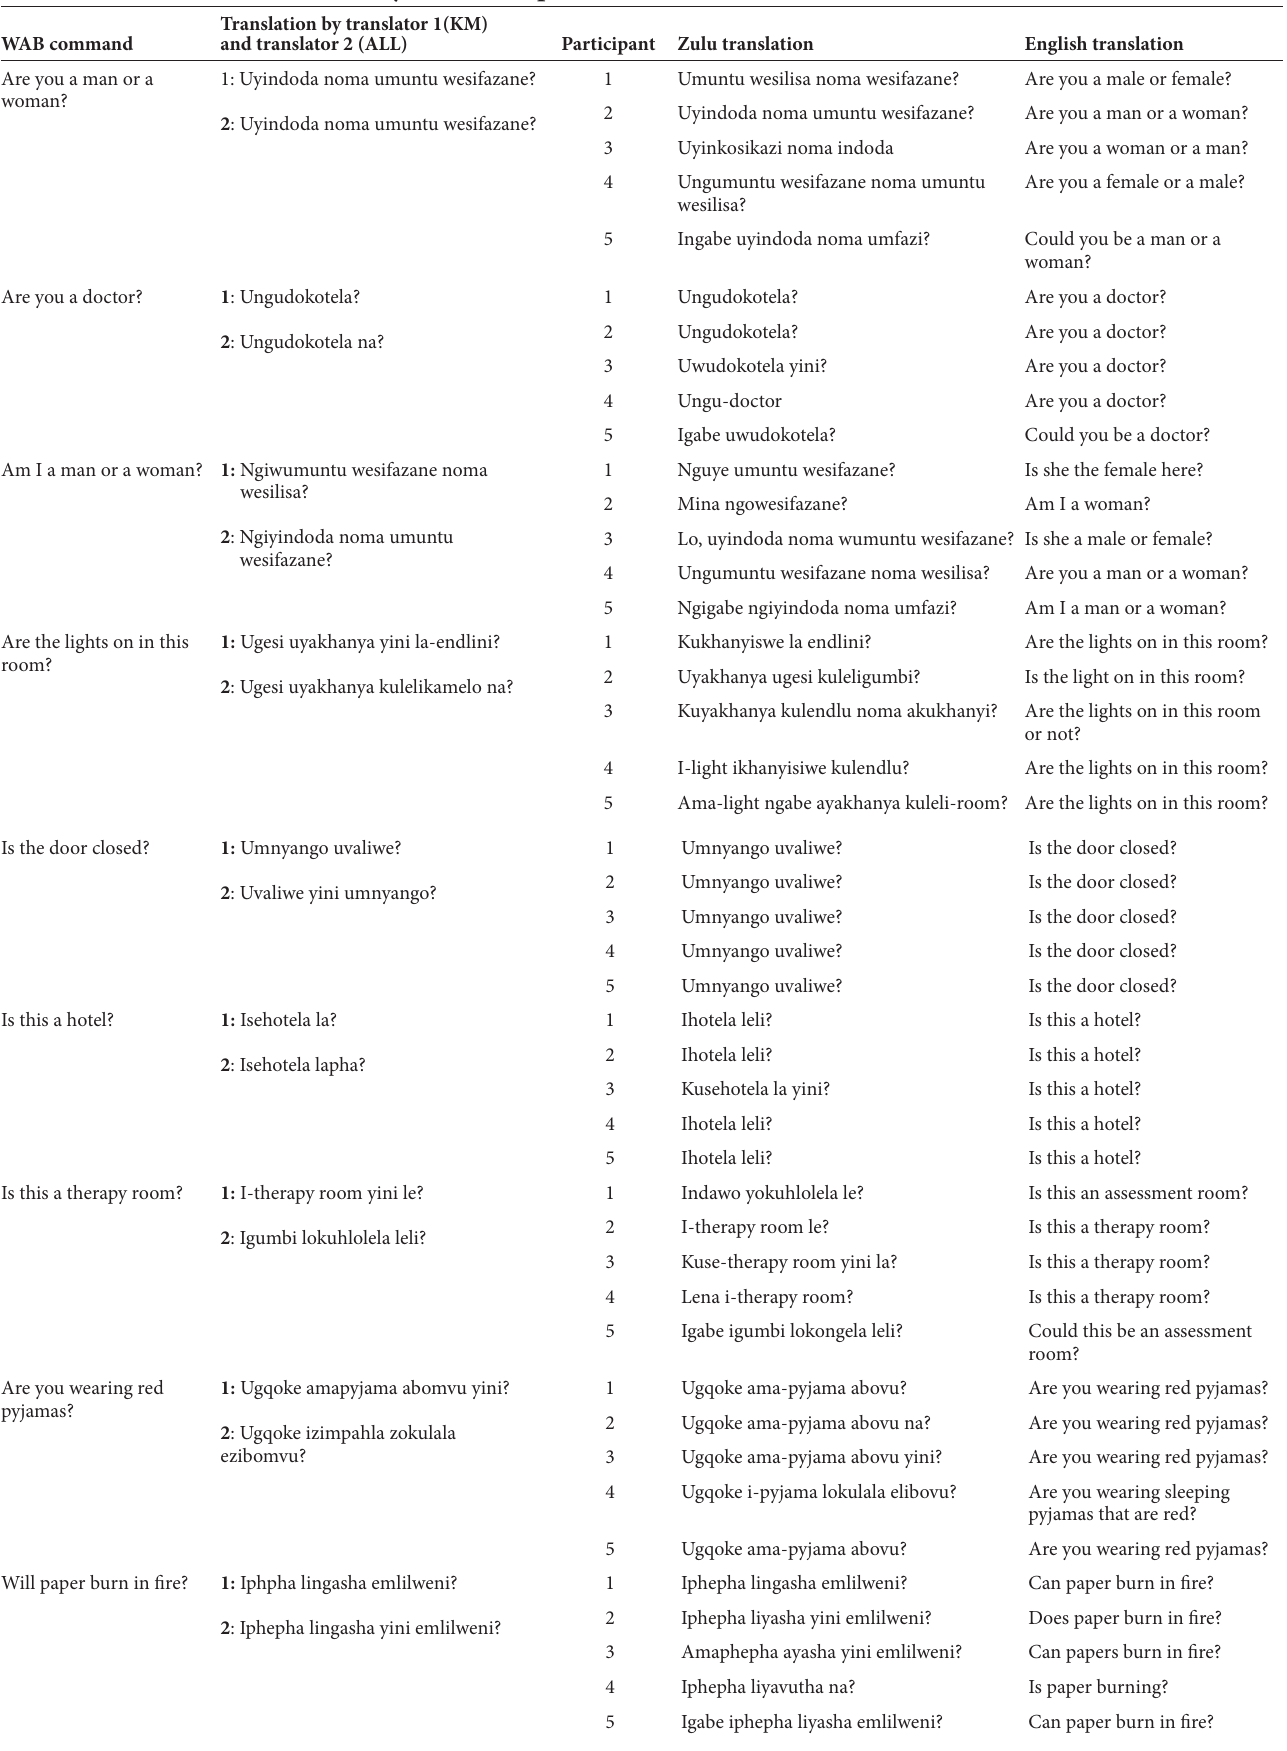
Table 2. Translation of the auditory verbal comprehension subtest of the WAB (continued) WAB